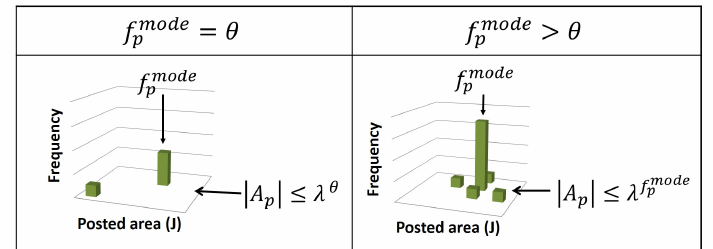
Figure 2. How the area-based frequency histogram F p is used to determine if w p represents a geospatial concept. Intuitively, by using the same threshold Th l , the threshold λ f mode p which represents the maximum number of sub-areas for extracting the geospatial concepts gets larger as the peak f mode p of the frequency histogram gets higher.